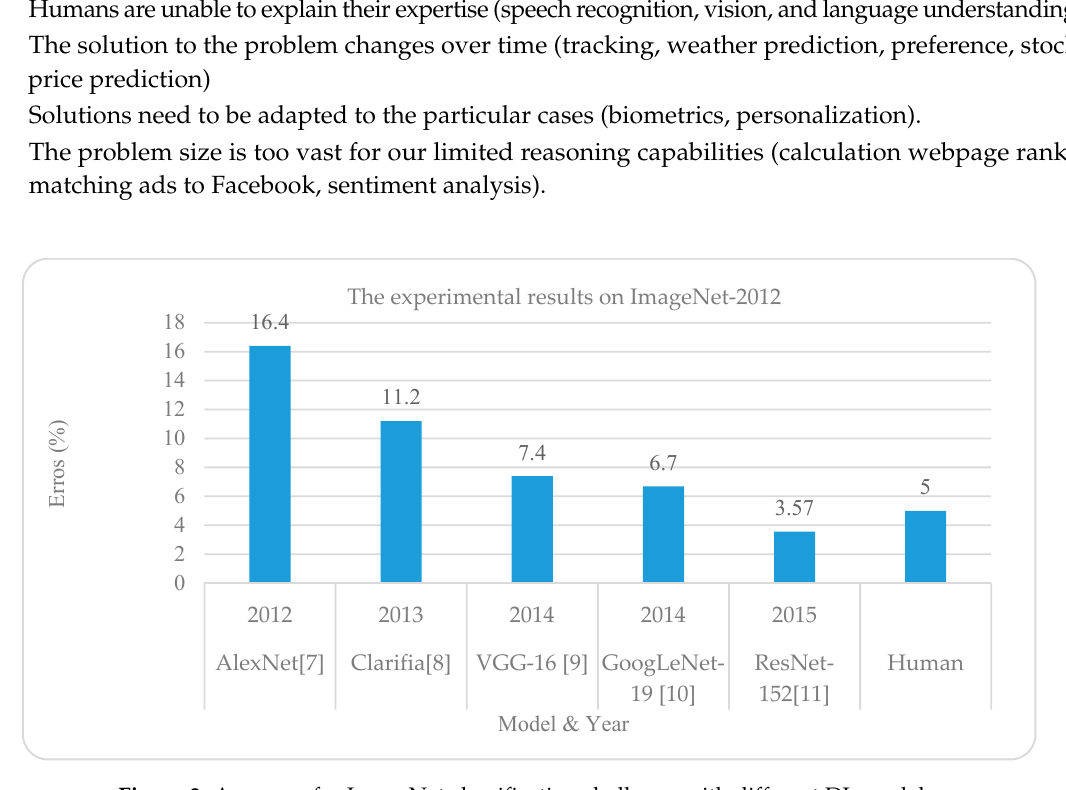
Figure 3. Accuracy for ImageNet classification challenge with different DL models.